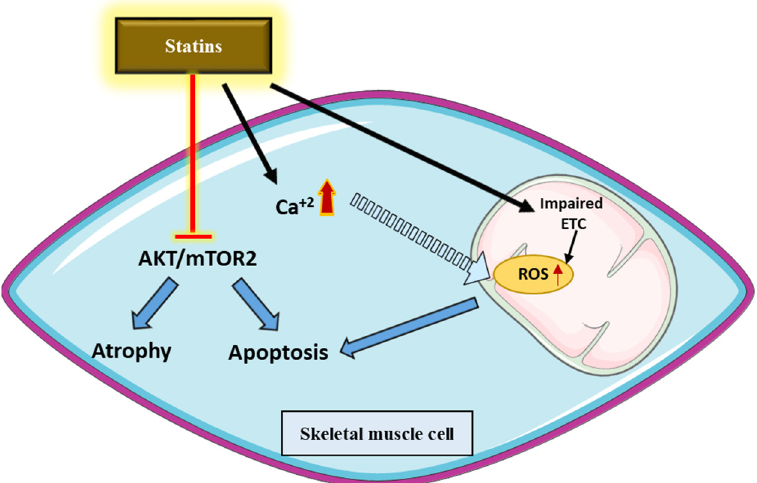
Figure 5. Off-target effects of statins. Statins act at different levels in skeletal muscle cells. First, they provoke the increased release of calcium from the sarcoplasmic reticulum to the cytoplasm and perturb the contractility of muscle fibers. In parallel, statins impair mitochondrial function, leading to the accumulation of ROS and to the activation of apoptosis. Finally, statins impair the function of Akt due to the impaired insulin signaling pathway and due to the impaired function of mTORC2. As a result, statins induce increased protein degradation and impaired protein synthesis, promoting skeletal muscle atrophy [95].